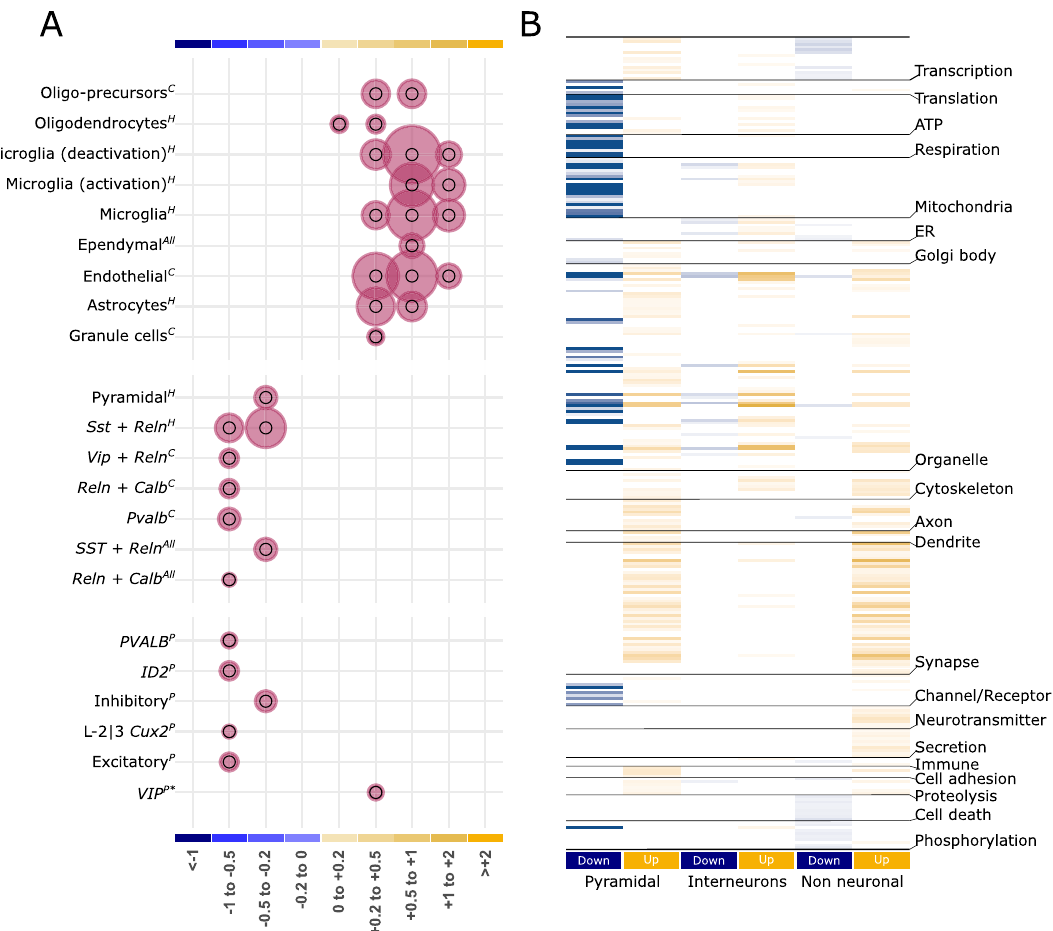
Figure 3. Validation of the cell-type deconvolution ( A ) and segregation of pathways affected by different cell classes ( B ). ( A ) Enrichment of cell-specific markers from an independent study within the log-fold change bins of differentially expressed genes. Note that enrichment does not provide detailed segregation of cell type, as observed in Fig. 2C. However, reflecting the increased proportion of non-neuronal cells, their enrichment is observed in the bins associated with upregulated genes. The size of the circles is proportional to the − log 10 value of the enrichment q value. Inner black circles represent the reference representing (q value = 0.05). Significant results (q value < 0.05) are plotted exclusively. Superscripts C, H, and All represents cell specific markers from cortex, hippocampus, and all brain region obtained from Mancarci et.al.; Superscripts P represents cell-specific markers from human TLE studies obtained from Pfisterer et.al. *For Vip-interneurons, to emphasize the similarity of increased proportion, p value < 0.05 is considered, ( B ) Pathways and themes (same as Fig. 1C) affected by cell-type clusters representing pyramidal, interneuron, and non-neuronal cells. The log 10 (q value) of each pathway was used to plot the heatmap. The lighter-to-darker shades of blue and yellow indicate increasing significance of down- and upregulated pathways, respectively. See Table S5 for additional